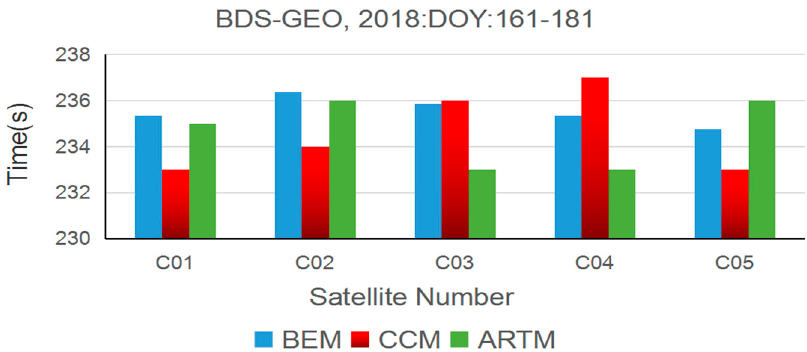
Figure 4. The mean shift time for BDS GEO satellites calculated by the three methods during DOY: 161–181, 2018.